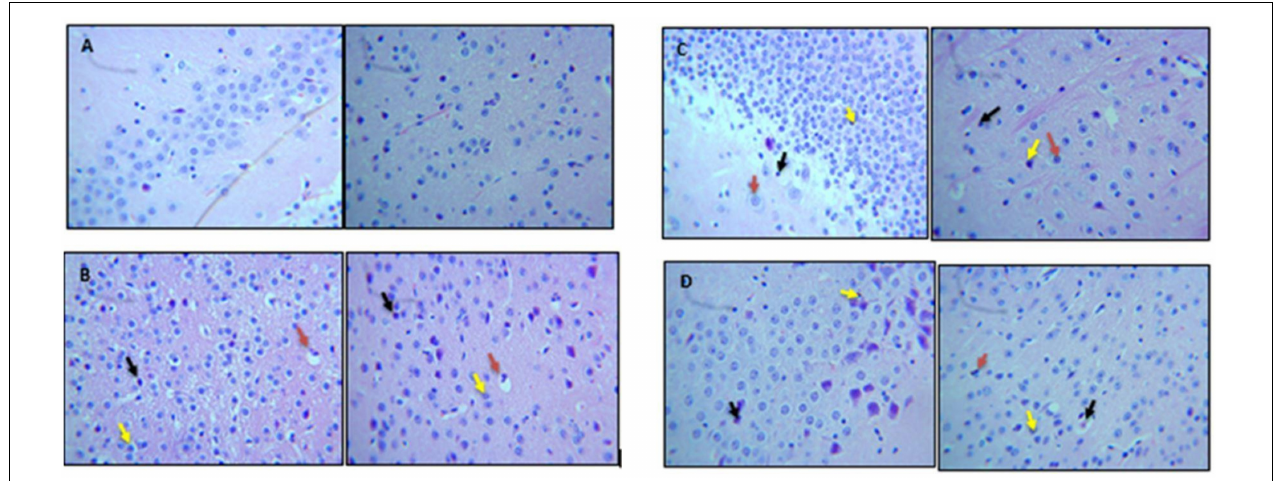
FIGURE 8 | Micrographs showing H&E staining of brain section. This figure represents histological images of (A) control, (B) Con-A, (C) Con-A+Dio, and (D) Con-A+Dio.SLNP groups. Red arrow: vacuolization; black arrow: pyknosis; yellow arrow: infiltration of inflammatory